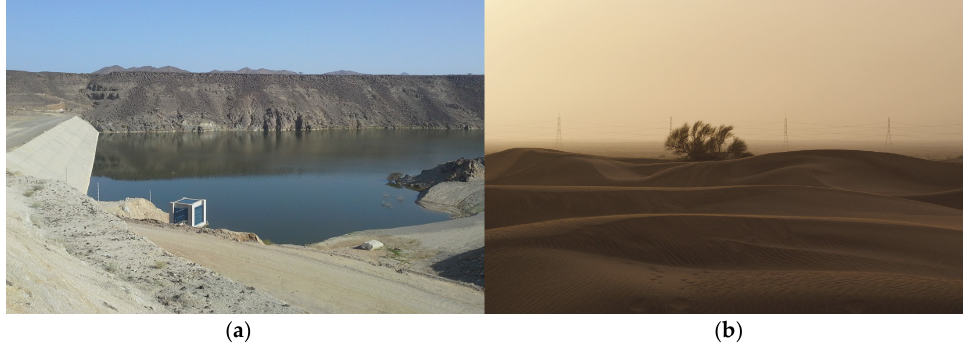
Figure 1. Wadi Khulays Dam and reservoir( a ) and the downstream dune field( b ), Lopez et al. [11].